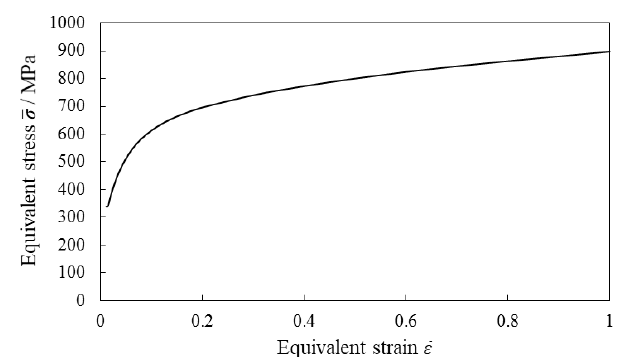
Figure 16. Flow curve of material of cold-forged hollow shaft S48C.